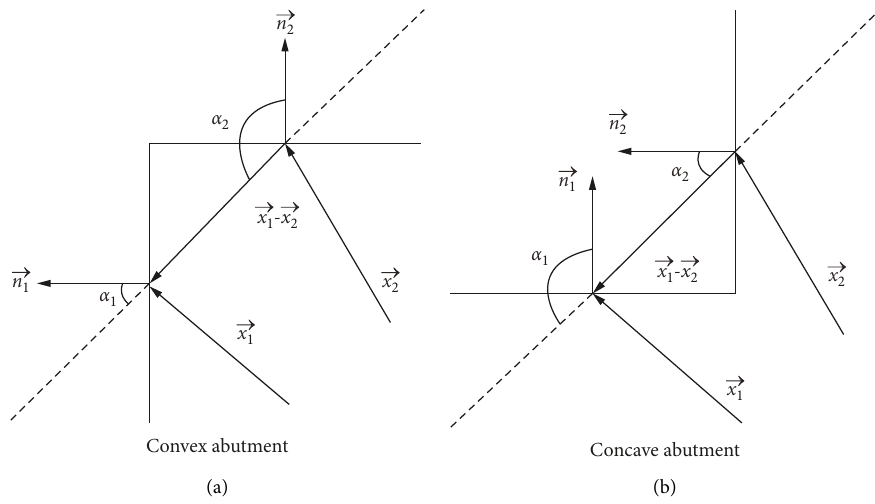
Figure 3: Convex abutment and concave abutment. (a) Convex abutment. (b) Concave abutment.